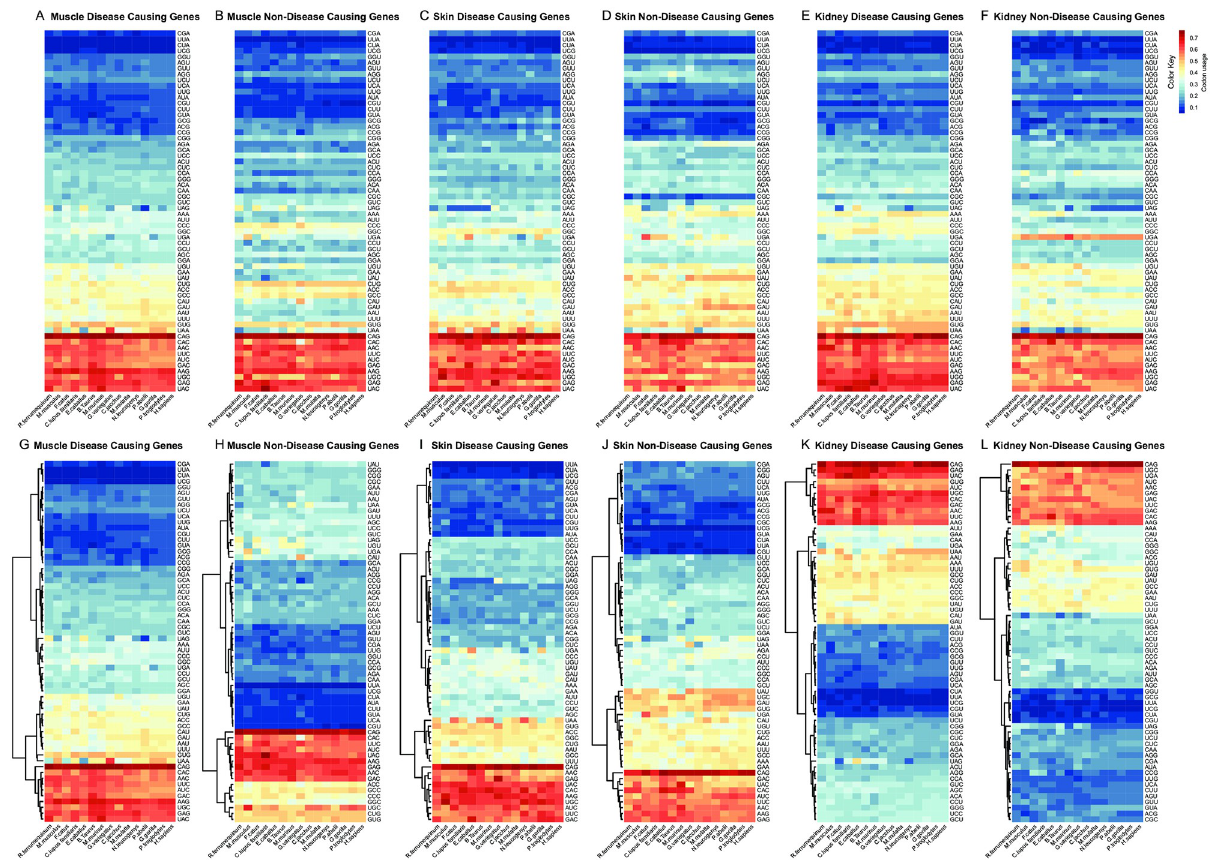
Fig 3. Comparison of relative synonymous codon usage (CUB) values in disease-causing (DC) and non-disease-causing (NDC) genes across species. Heat plots were generated using R package gplots. Rows were clustered based on Euclidean distance. The key color coding varies from blue to red with low to high values of the CUB respectively. We grouped genes based on their propensity to be the site of pathogenic variations (mutations) causing rare diseases (disease causing or DC genes). Panels A to F shows all types of codons with no hierarchical clustering, listed in the same order in all genes and tissues, and sub-grouped in DC and NDC. CU values in these panels show that the most frequent or rarest codon types are overlapping in gene groups. Two groups of dark blue and dark red color key codons occur in all 6 panels, indicating that absolute frequency of codon types is similar also across genes and mammals, possibly supporting an evolutionary trend of CUB. Nevertheless, CU value higher variability can be seen in codons with intermediate frequency (light blue to yellow key colors) which differ across gene groups. Muscle NDC genes (panel B) do have the lower number of intermediate (yellow key color) CU values, followed by skin DC (panel C) and kidney NDC (panel F). CAG is the most frequently used and UUA is the less frequently used codon in all genes and across mammals. Panels G-L show hierarchical clustering of CU values in the same categories and groups. Clearly recognizable CUB fingerprints can be observed in DC and NDC genes. This is massively evident in muscle genes (panel G and H) and also partially in kidney genes (panel K and L). DC muscle genes have compact clusters of extremely frequent codons (AAG, CAG, GAG) and extremely rare codons (UGG, UUA, CUA), a trend conserved across mammals and with clearly defined codon groups in terms of tree distance. Dark blue and red (more rare and frequent codons) colors predominate in muscle NDC genes, with a few codons with intermediate (yellow color key) values. This suggests that a strong CUB has occurred in NDC genes. Accordingly, muscle NDC genes show higher and lower CU values clustered together, suggesting a possible different evolutionary trend. Skin DC and NDC genes (panels I-J) show similar CUB fingerprints with a few differences. Skin NDC genes show overall lower CU values (panel J, upper side) and conversely more codons with intermediate CU values (panel J, downside) compared to DC genes. Kidney DC and NDC gene (panels K-L) CUB fingerprints greatly differ from the other two groups since the hierarchical clusters are opposite. Although conservation of CU values across mammals also occurs, the hierarchy of kidney gene dendrograms shows a common ancestor for intermediate and low CU values and not two distinct lineages (high and low CU values) as observable in muscle and skin genes. The two kidney CUB fingerprints are somehow similar; however, DC genes show a higher number of very low CU